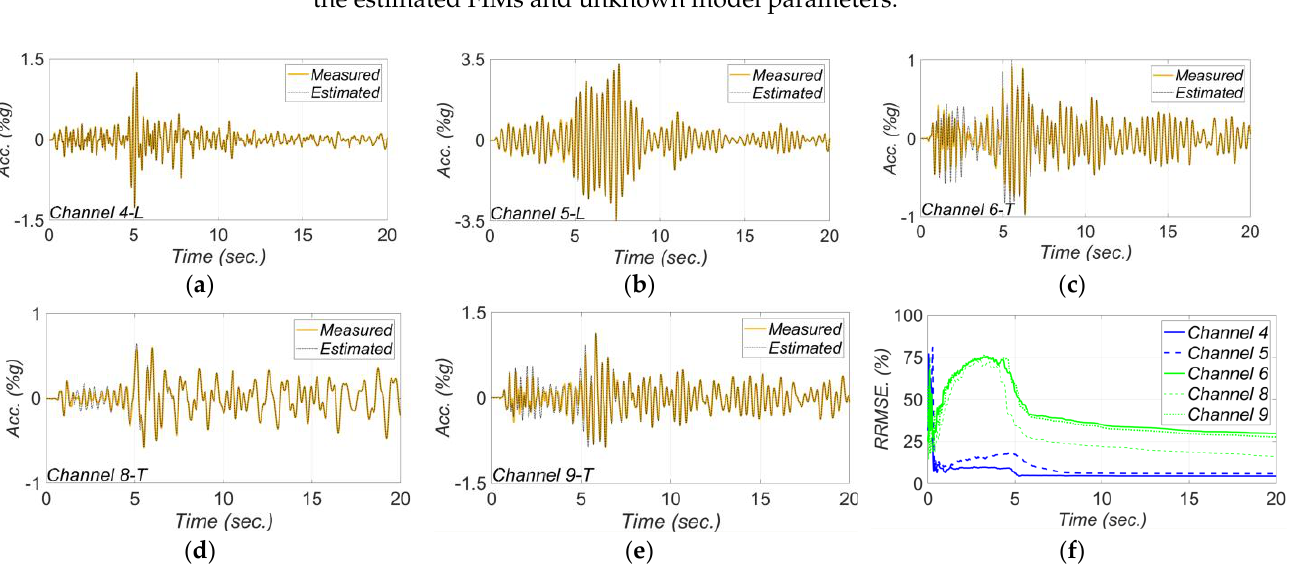
Figure 11. Comparison between measured and estimated responses obtained from the updated FE model at: ( a ) channel 4, ( b ) channel 5, ( c ) channel 6, ( d ) channel 8, ( e ) channel 9. Part ( f ) is the corresponding RRMSEs.